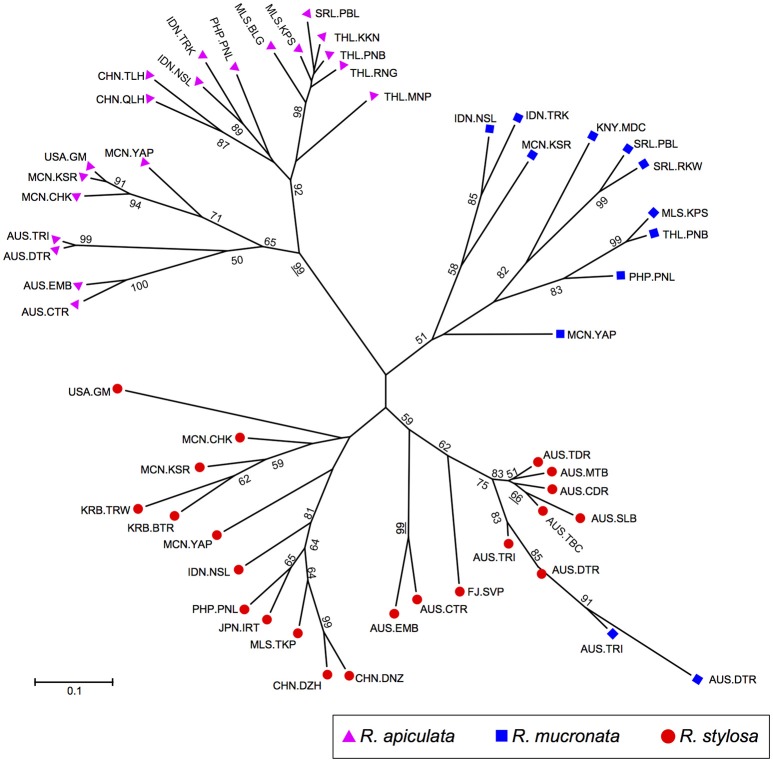
Neighbor-joining tree based on Nei's genetic distance showing relationships among Rhizophora populations. Purple triangles, R. apiculata; Blue squares, R. mucronata; and red circles, R. stylosa.